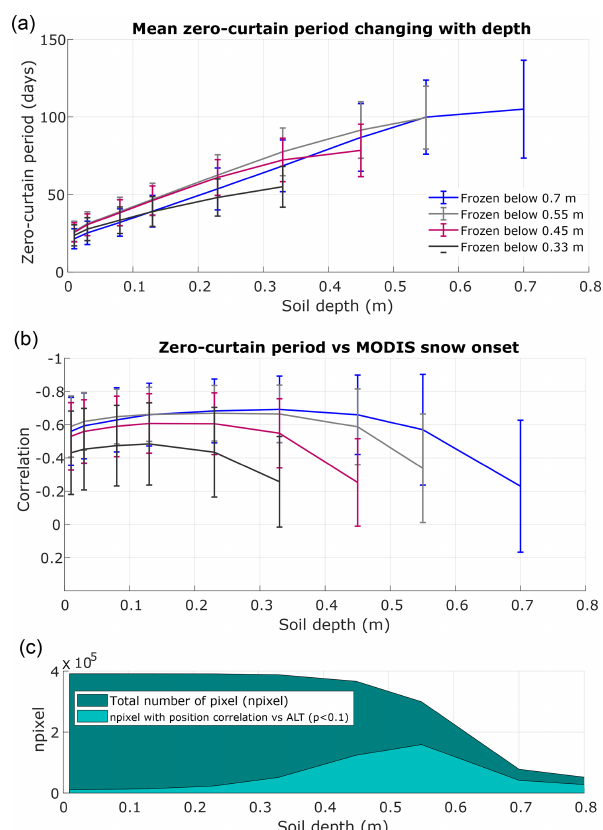
Figure 10. Regional statistics of model-simulated zero-curtain period (a) and its sensitivity to MODIS snow onset and model-simulated ALT (b–c) from 2001 to 2016: (a) regional mean of model-simulated zero-curtain period at different depths; (b) changes in correlations between snow onset and zero-curtain period with depths; for both (a) and (b) , the study area was di- vided into four groups: soil column froze below 0.33, 0.45, 0.55 and 0.7m. The soil column for the majority of the study area froze below 0.7m. (c) The proportion of pixels with a significant positive correlation between the zero-curtain period and ALT at different depths. The total number of unfrozen pixel was shown as